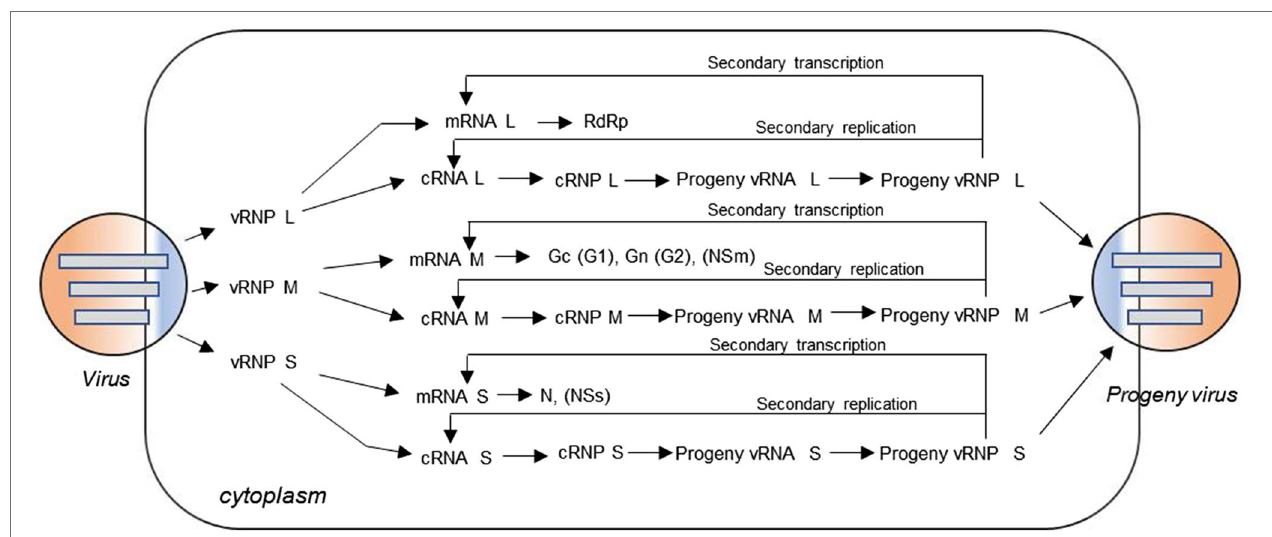
FIGURE 2 | Virus replication cycle of typical three-segmented bunyaviruses in the cytoplasm. The viral genomic RNA is always encapsidated by N protein and associated with L protein to form ribonucleoprotein (RNP) complexes in the virion. After virus entry, uncoating occurs and the genomic RNAs with some specific viral proteins can be used to initiate transcription of positive-sense messenger RNA (mRNA) and the intermediate product cRNA. The mRNA can serve as a template for viral protein synthesis, such as L protein, Gc (or G1), Gn (or G2), NSm, N, and NSs; and the cRNA coated by N can recruit L protein to form functional cRNPs, which can serve as templates to synthesize progeny vRNAs. Similarly, after recruitment and encapsidation, the progeny vRNPs are formed and then packaged by glycoprotein into progeny viruses. Meanwhile, the nascent vRNP can also be used as templates to synthesize cRNA and mRNA through the so-called secondary replication and secondary